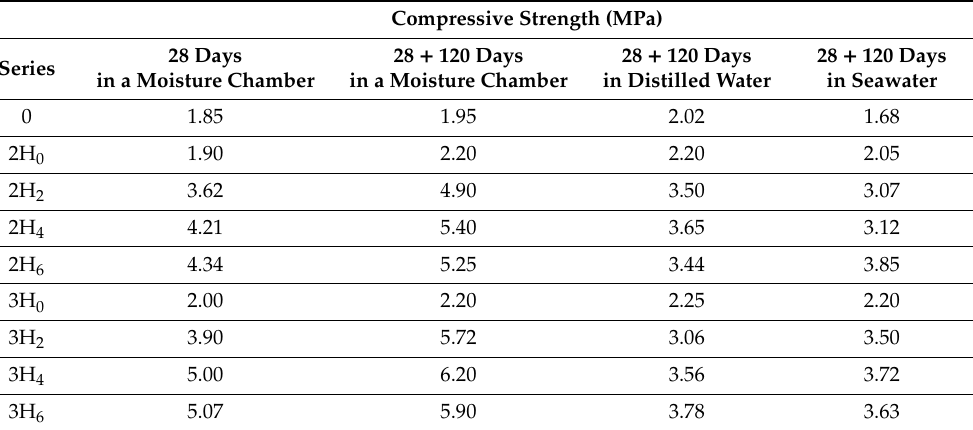
Table 4. Results of the compressive strength of the 28-day and 148-day samples as well as the 28-day samples after 120 days of submersion in distilled water and seawater.